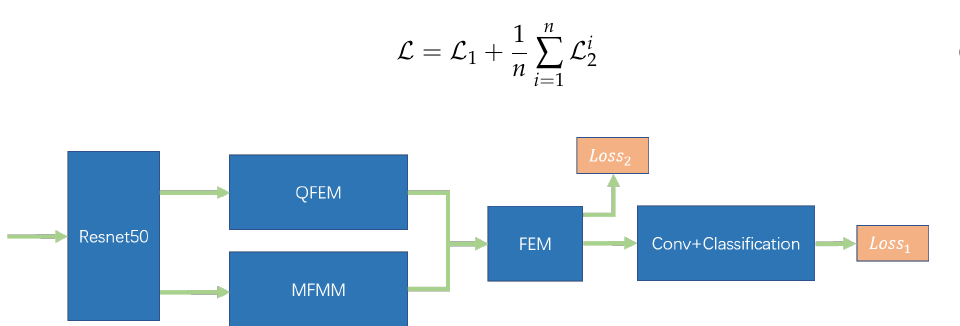
Figure 7. The losses come from two aspects of the model.